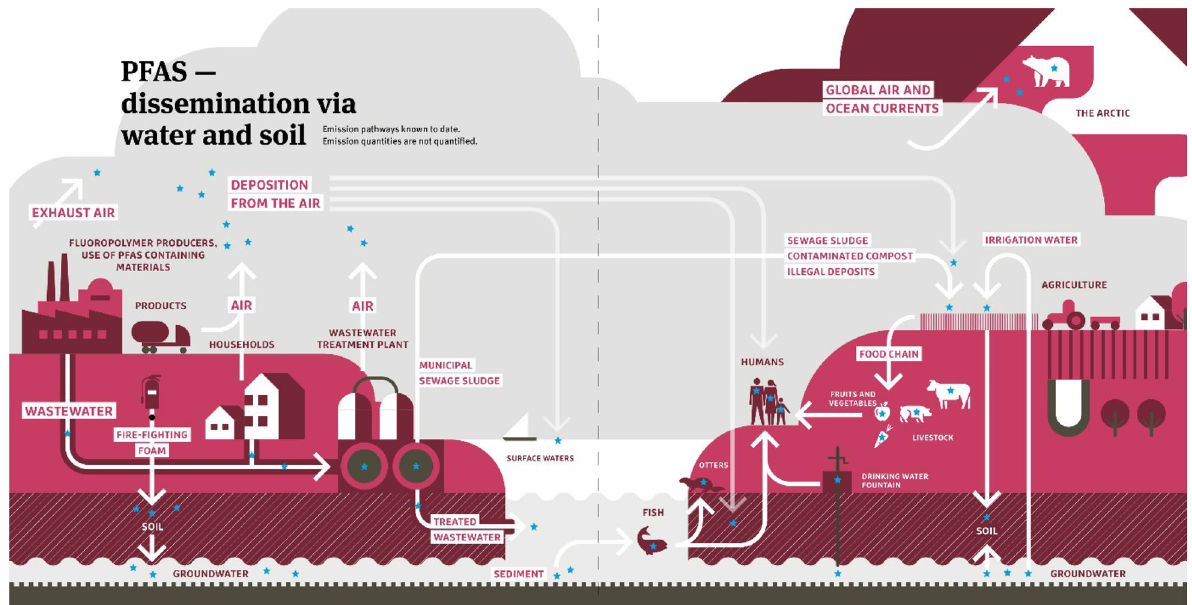
Fig. 5 Dissemination of PFAS via water and soil © UBA